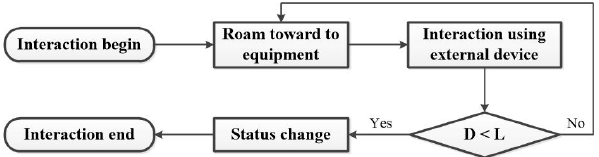
Figure 6. The flowchart of equipment